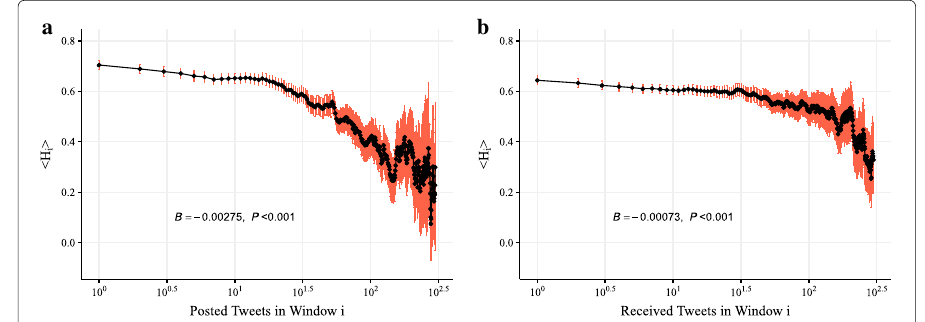
Fig. 5 Mean entropy (cid:4) H i (cid:5) and 95% CI of topics in ( a ) posted and ( b ) received tweets over sliding windows with a size of k = 10. CI become wider due to the decreased sample sizes of users having a large number of tweets. Legends report estimated coefficients B and p -values in a linear regression model: (cid:4) H i (cid:5) = Bi + (cid:9) , where estimations are based on windows over i ∈ [1,150] due to relatively small mean errors in this